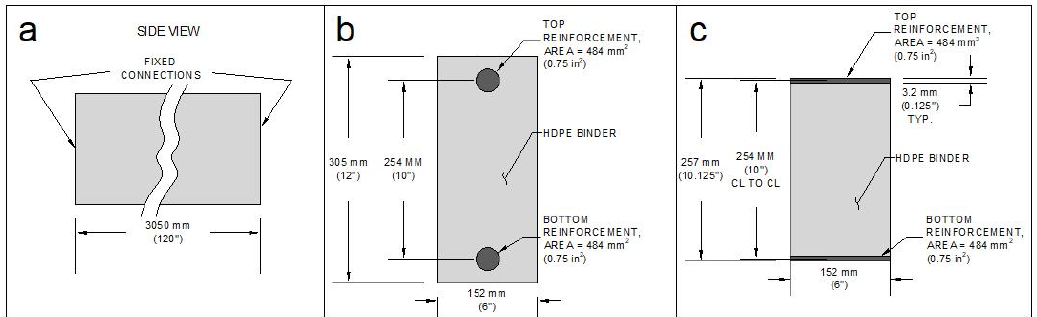
Figure 7. The dimensions utilized for the FEM of the triple composite beams. ( a ) Side view showing the length of the beam. ( b ) The configuration used for rod-type reinforced models. ( c ) The configuration used for double-plate reinforced beams. Note that the reinforcement spacing was maintained between cross-sections (b and c) to provide comparable stresses between the two cross- sections.